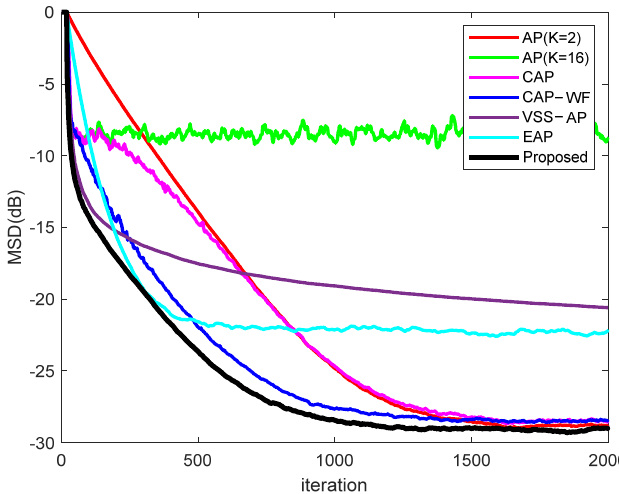
Figure 3. Convergence curves of the proposed algorithm and the conventional AP, CAP, CAP − WF, VSS − AP, and EAP algorithms in a stationary environment with SNR = 20 dB.